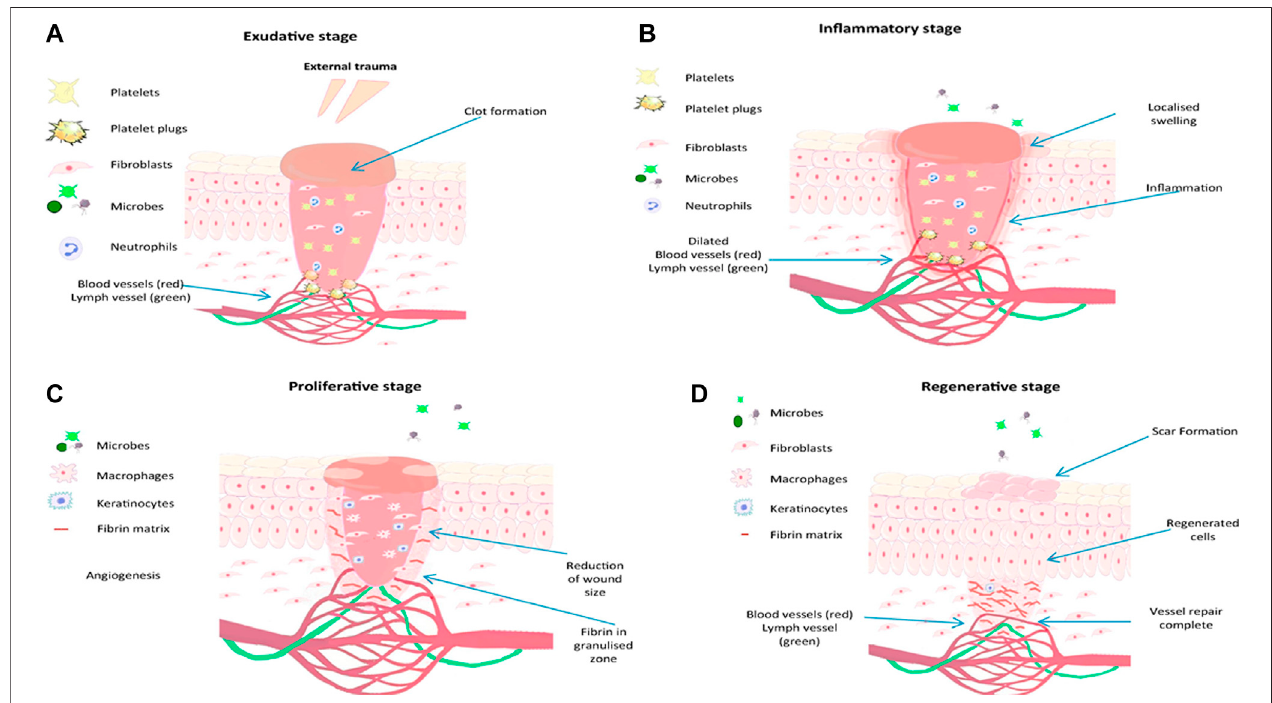
FIGURE 1 | Representation of steps involved in wound the healing process, reproduced with permission from Gupta et al. (2019), (A) exudative stage with the formation of blood clot, (B) in fl ammatory stage, marked with oedema, pain and in fl ammation, (C) proliferation stage with granulation tissue formation and (D) regenerative stage, characterised by scar tissue